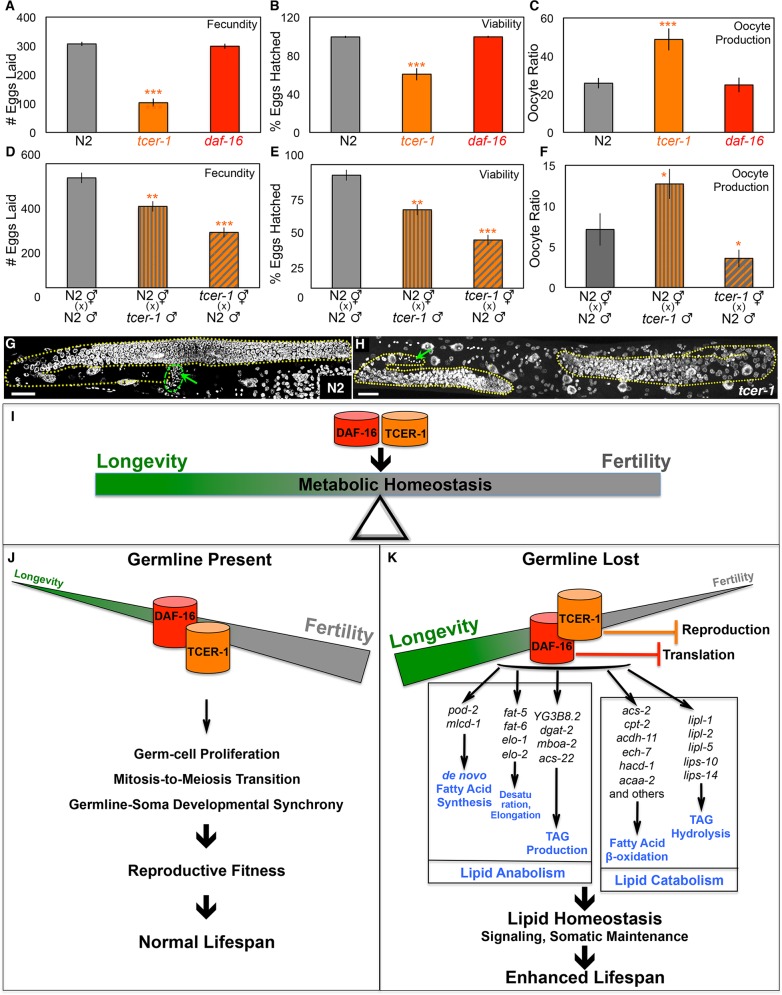
TCER-1 promotes reproductive health in normal, fertile worms and metabolic homeostasis and longevity in germline-less animals.A-C.
tcer-1 mutants exhibit multiple fertility defects. Reproductive fitness parameters compared between wild type (N2, gray), daf-16 (red) and tcer-1 (orange) mutants, including fecundity (number of eggs laid, A), viability (percent of laid eggs that hatch successfully, B), oocyte production (C) grown at 20°C. tcer-1, but not daf-16, mutants are defective in all aspects and these phenotypes are aggravated further at 25°C (S4C Fig). D-F.
tcer-1 mutants make defective sperm and oocytes. Functionality of tcer-1 mutants’ sperm and oocytes was assessed by crossing tcer-1 males to wild-type (N2) hermaphrodites (vertical striped bars) and tcer-1 hermaphrodites to N2 males (diagonal striped bars), respectively. Reproductive health measures were compared against control N2 hermaphrodites and males crossed to each other (gray bars). Shown here are results for fecundity (D) viability of eggs (E) and oocyte production (F). G, H.
tcer-1 mutants exhibit inadequate germ-cell development and germline heterochrony. DAPI stained germline of wild type (N2) day 1 adults germ cell nuclei organized in spatial-temporal gradient, whereas, gonads from tcer-1 mutants exhibit significantly reduced germ-cell number. Gonads are outlined with yellow, dotted lines and scale bar in both images is 20μM. Germline heterochrony in the mutants is revealed by the presence of sperm (green arrows) within the proliferating region of the gonad and not within the spermatheca (demarcated with a green dotted line) as seen in N2. Quantification of germline defects is shown in S4 Fig. In A-F, asterisks represent the statistical significance of differences observed in an unpaired, two-tailed t-test with P values 0.05 (*), 0.005 (**) or < 0.0005 (***) between N2 and tcer-1 (orange asterisks) or daf-16 (red asterisks). I-K. Schematic representation of the model proposed based on the findings of this study. Our results suggest mechanisms by which DAF-16 and TCER-1 help maintain metabolic homeostasis in response to changes in the reproductive status of the animal (I). In fertile animals, TCER-1 ensures reproductive fitness, likely by promoting germ-cell proliferation and successful sperm-to-oocyte production switch in synchrony with somatic development (J). When the germline is lost, as in the case of glp-1 mutants, TCER-1 undergoes a role-reversal and inhibits the somatic program of reproduction instead (K). TCER-1 also represses anti-longevity genes independently. DAF-16, on the other hand restrains translation by repressing ribosomal-gene expression (K). Additionally, DAF-16 and TCER-1 enhance the expression of genes involved in both lipid-anabolic and lipid-catabolic pathways (depicted in K) in adaptation to germline depletion. We posit that the simultaneous enhancement of these ostensibly antagonistic processes (a) allows the animal to retain metabolic homeostasis during the physiological flux caused by germline loss, and (b) enables the production of lipid signaling moieties and/or ligands for transcription factors whose activities ultimately advance longevity.